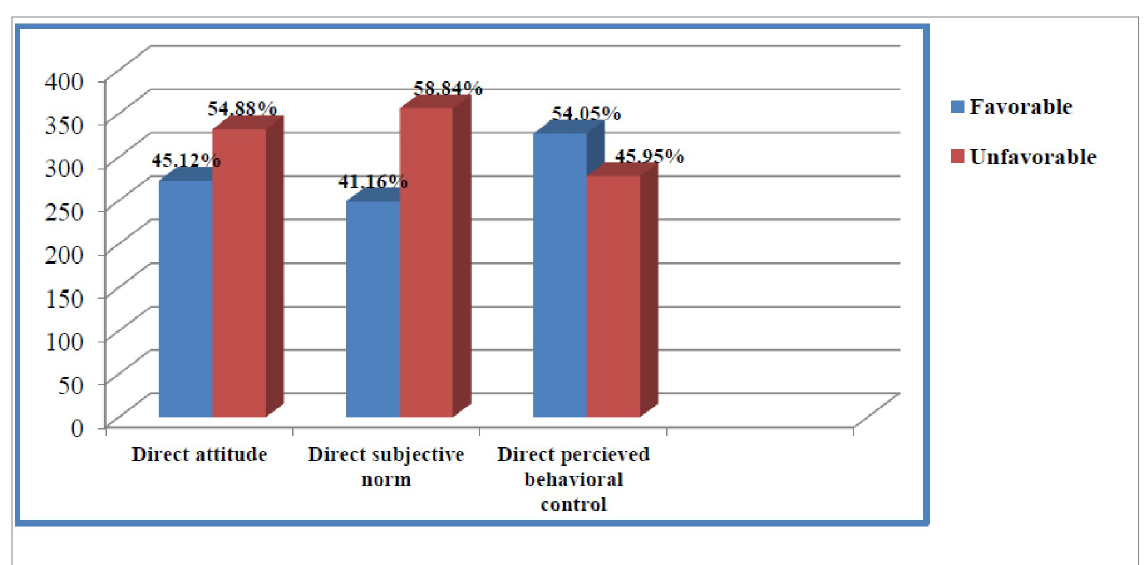
Fig 2. Proportion of direct components of theory of planned behavior among pregnant women in Gamo Gofa zone, Southern Ethiopia, 2019.